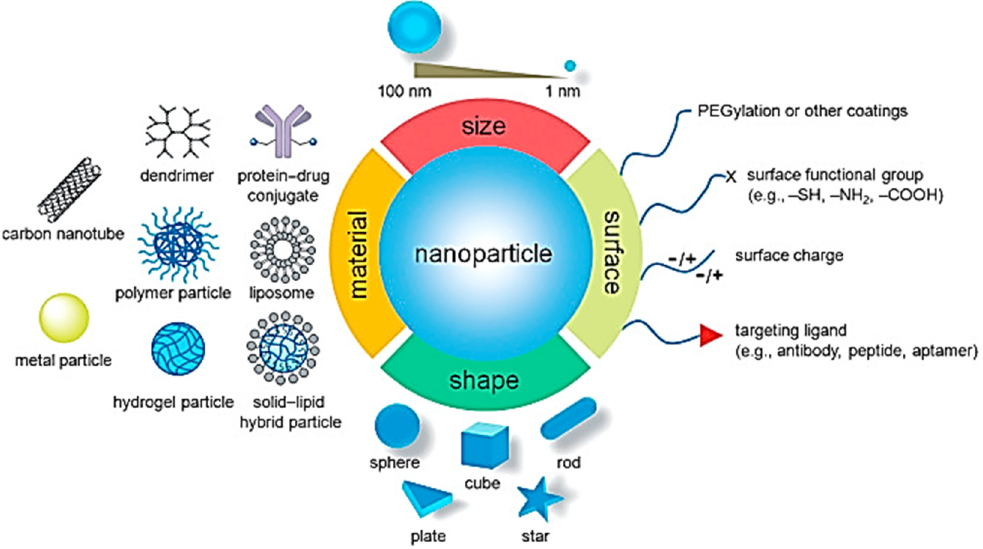
Figure 2. Various morphologies of nanoparticles and their applications in biomedical fields. Reprinted with permission from ref. [2]. Copyright 2014 Copyright John Wiley and Sons.